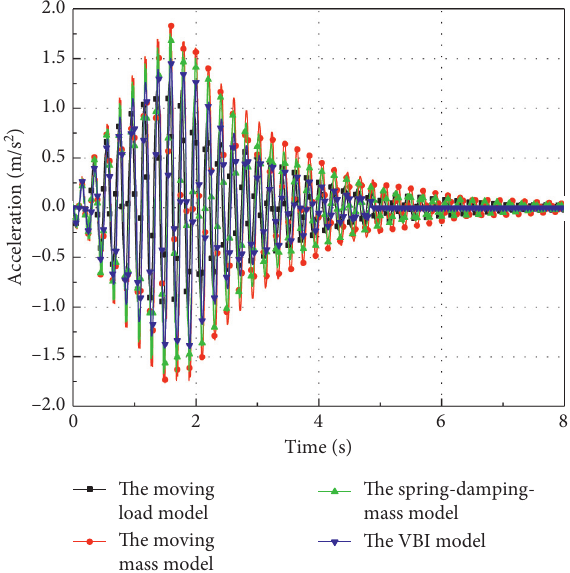
Figure 9: The maximum acceleration of the bridge under the four models at different speeds.